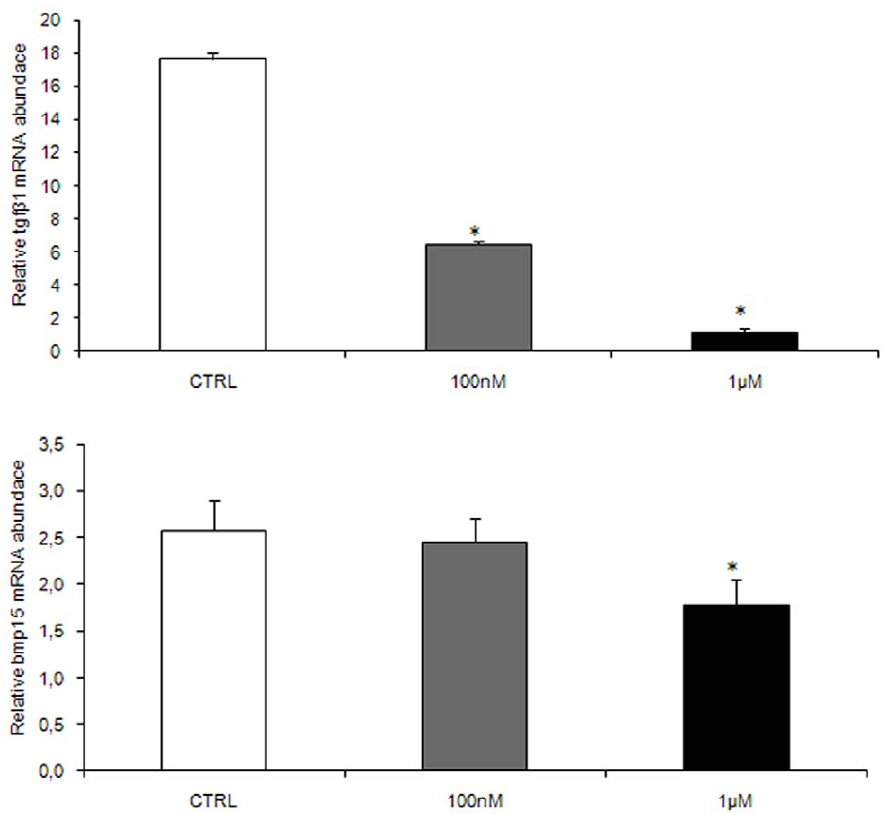
Figure 4. Invivo effects of melatonin on factors preventing precocious follicle maturation. (A) tgf b 1 and (B) bmp15 mRNA levels, normalized against b -actin gene in fish exposed to 100 nM and 1 m M MEL. n=15 per group Error bars indicate mean 6 S.D. Asterisks denote exposure groups that are significantly different from the relative control group (CTRL) (p , 0.05), analyzed using ANOVA followed by Bonferroni’s multiple comparison test.